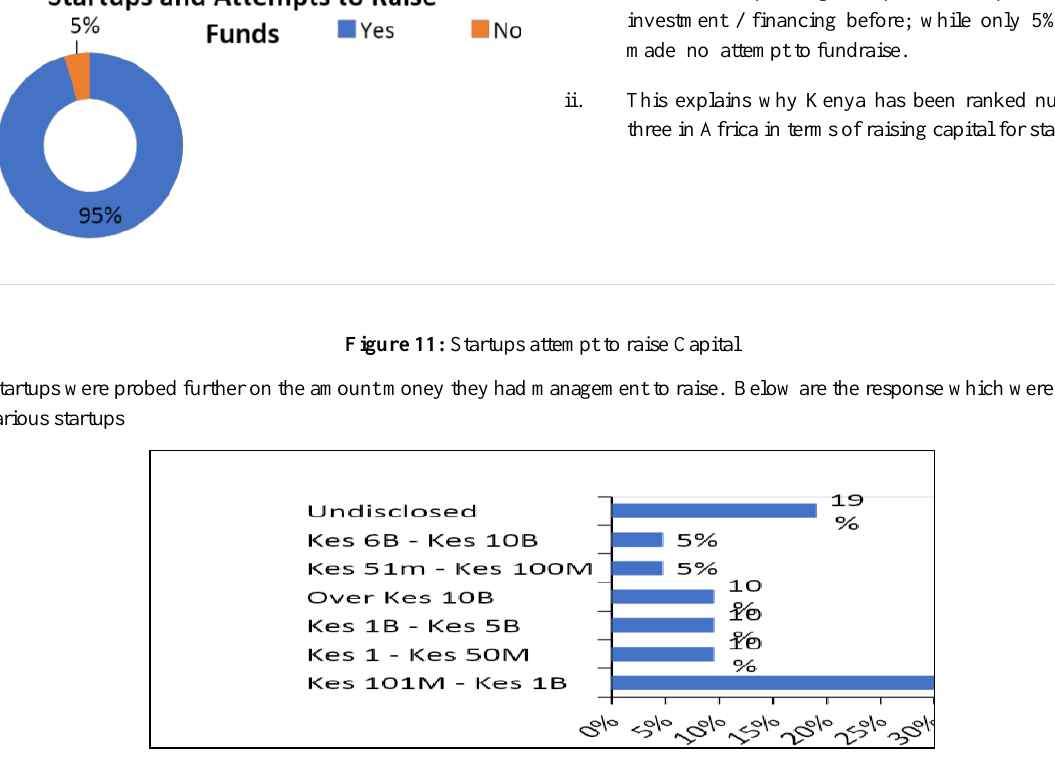
Figure 12: Amount of Finance